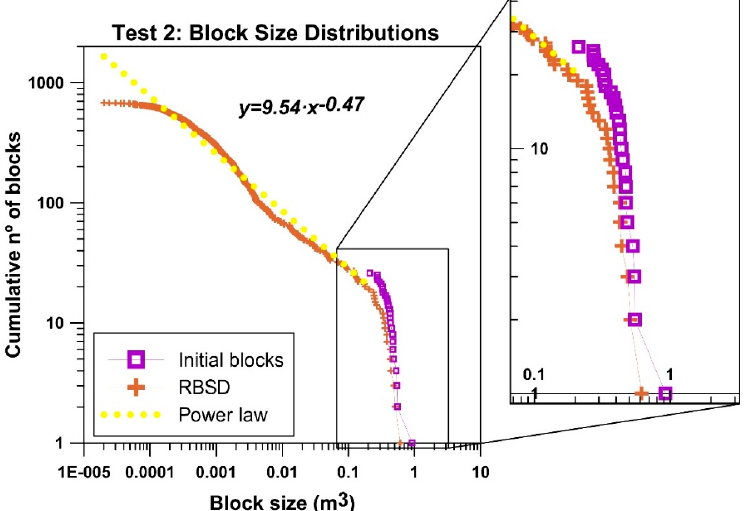
Figure 12. Initial block size distribution (purple) and Rockfall Block Size Distribution (RBSD, all the fragments measured together) obtained in test 2.